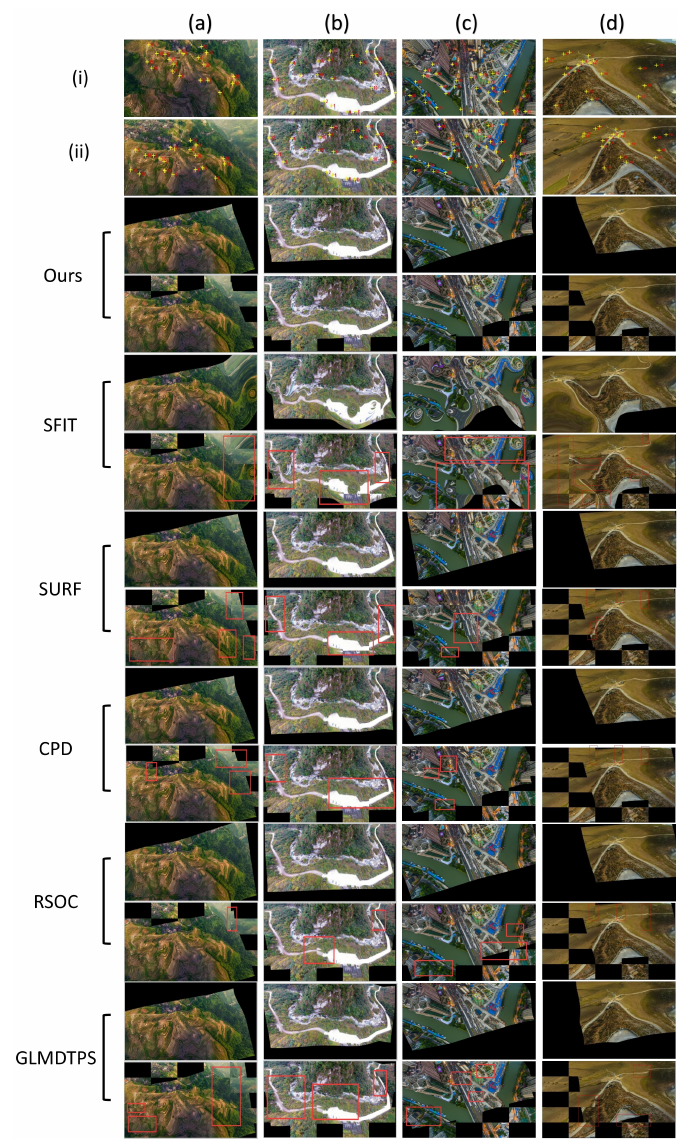
Figure 11. Registration examples on four typical image pairs from dataset (ii). The first two rows: the sensed and reference image, with the yellow crosses denoting the landmarks. Rows from the third to the end are the registration results of ours, SIFT, SURF, CPD, RSOC and GLMDTPS. For each method, the registration results are shown using two rows, with the upper row showing the transformed image, and the lower row showing the 5 × 5 checkboard. The registration errors are highlighted using the red